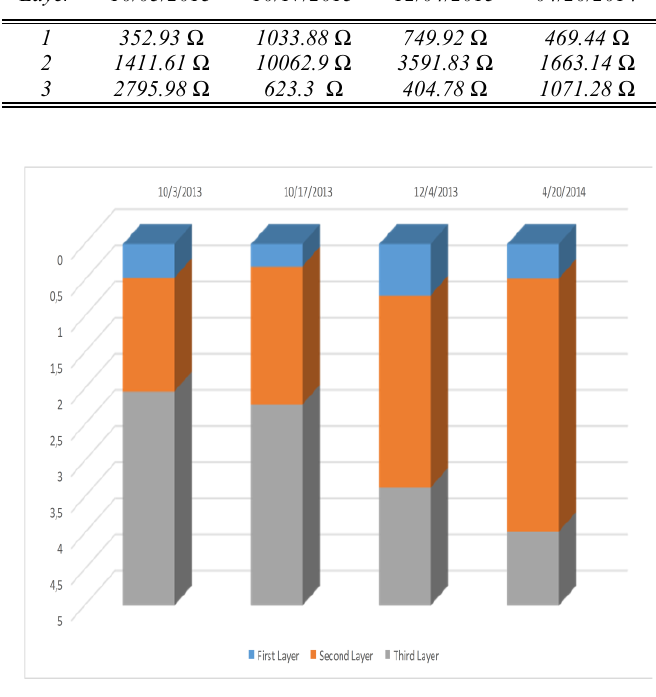
Fig. 9. Chart the depths of soil